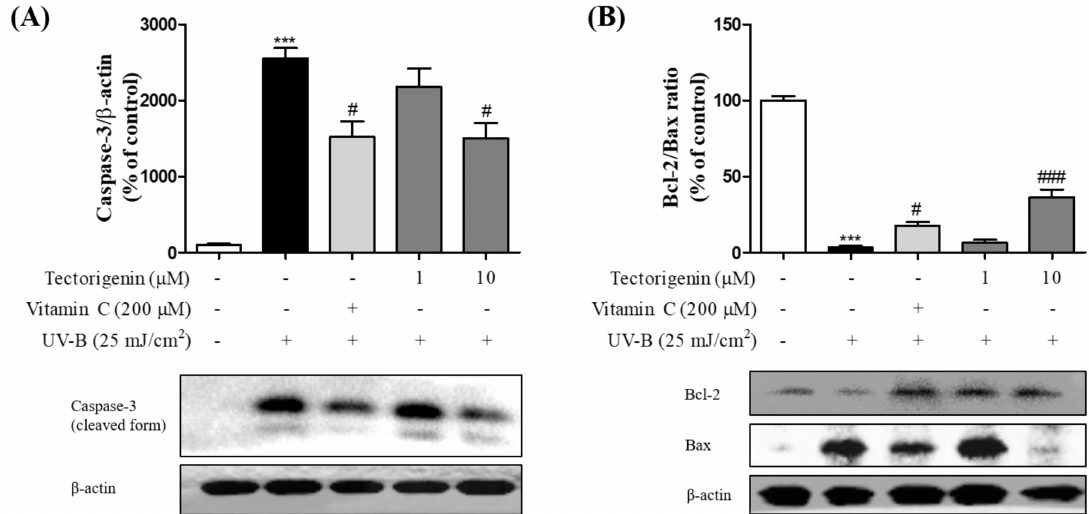
Figure 5. Inhibitory effects of tectorigenin on the UV-B-induced expression of cleaved caspase-3 and downregulation of the Bcl-2/Bax ratio in HaCaT cells. The cells were irradiated with 25 mJ/cm 2 UV-B and treated with tectorigenin at 1 and 10 µ M or vitamin C at 200 µ M for 24 h ( A , B ). Caspase-3 levels and the Bcl-2/Bax ratio were measured by Western blotting. Values are given as the mean ± SEM. *** p < 0.001 versus control group, # p < 0.05, ### p < 0.001 versus UV-B-only treated